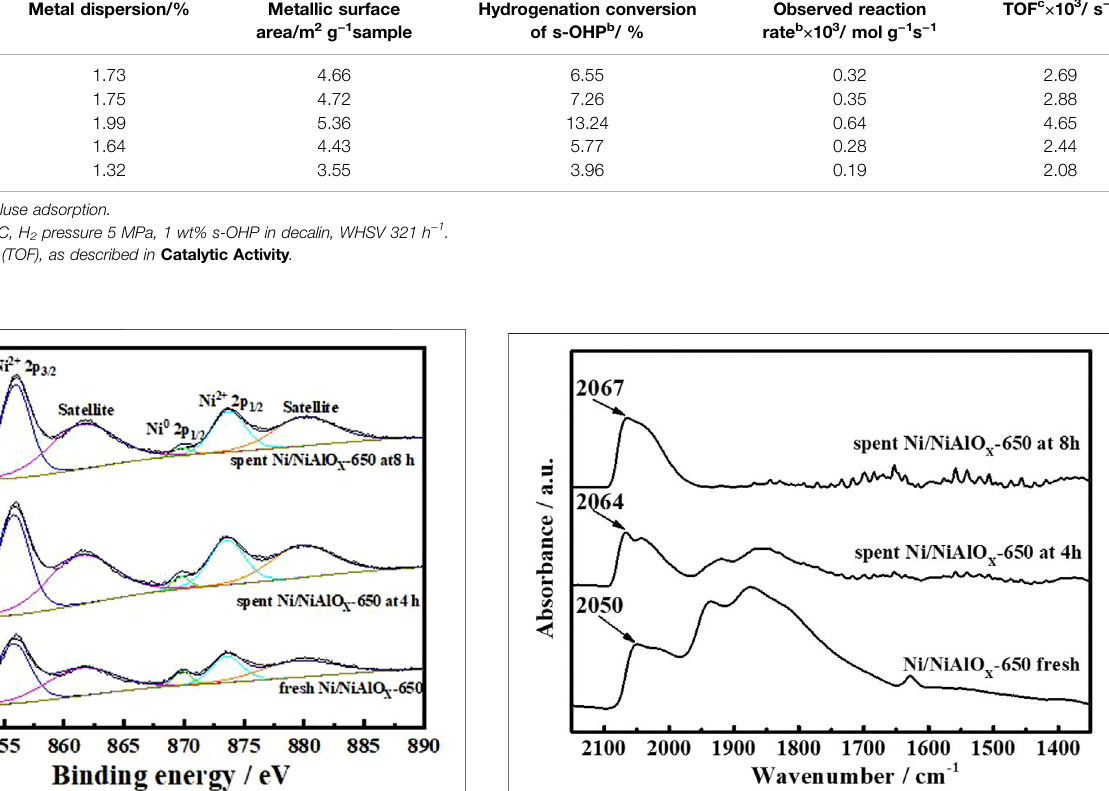
TABLE 2 | Metal dispersion and reactivity of Ni/NiAlO X catalysts with different calcination temperatures. Catalyst